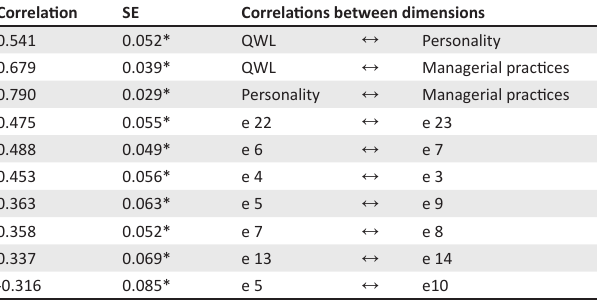
TABLE 5: Structural equation modelling correlations coefficients between organisational trust and quality of work life. Correlation SE Correlations between dimensions